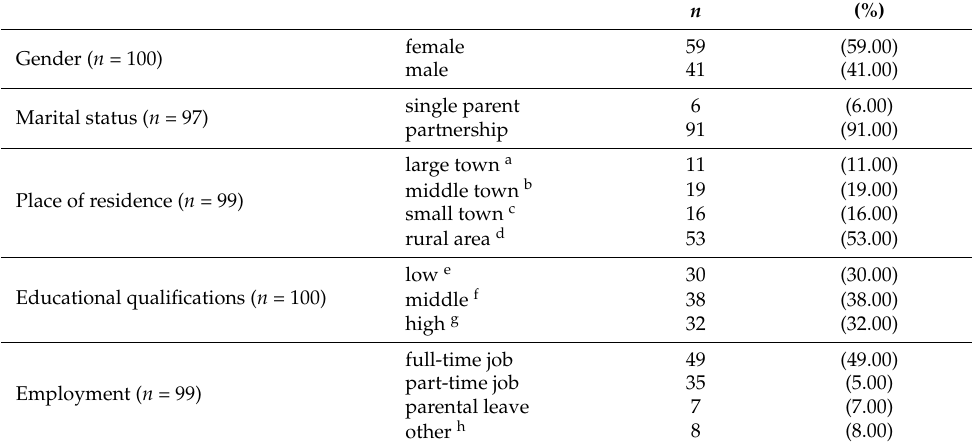
Table 1. Data of Parents’ Characteristics ( n = 100).